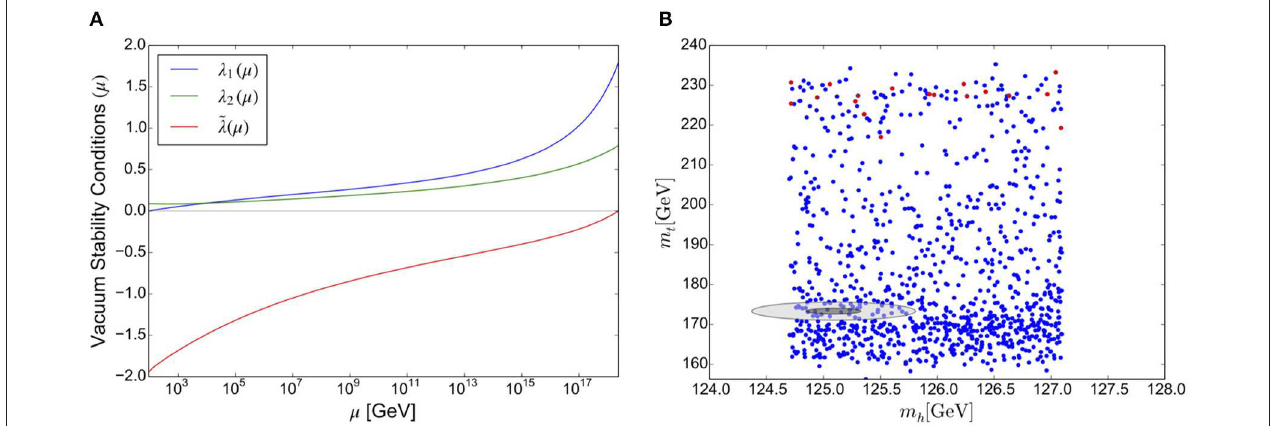
FIGURE 8 | (A) Example running of λ 1 , λ 2 , and ˜ λ for a point that provides valid masses for the SM Higgs and the top quark in the Type-II Two Higgs Doublet Model. Boundedness from below and vacuum stability requires that all three couplings are positive at all scales. (B) Results of our Multiple Point Principle scan in the m h plane of the Type-II Two Higgs Doublet Model. The blue points provide valid SM higgs masses whilst the red points also pass the vacuum stability conditions at all scales. The ellipses show the experimentally allowed values of m t and m h at 1 σ (dark gray) and 3 σ (light gray) uncertainty. These plots originally appeared in McDowall and Miller [ 71].